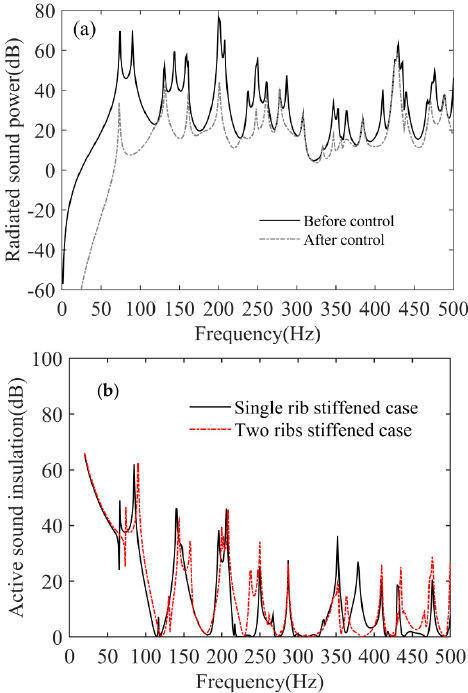
Figure 5. The radiated sound power of the ribbed plate B before and after control. ( a ) For the orthogonally ribbed case. ( b ) Comparing the control effect between the single ribbed case and the two ribs stiffened case.